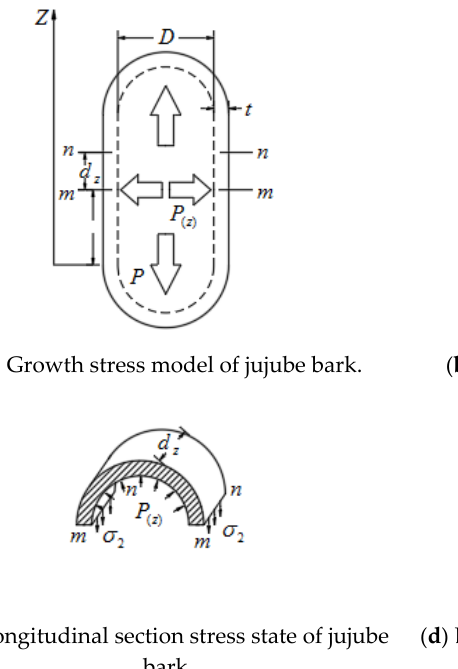
( a ) Jujube trunks for making bark samples. ( b ) Jujube bark samples for longitudinal tensile test. Figure 2. Longitudinal tensile test samples of jujube bark. Figure 2. Longitudinal tensile test samples of jujube bark.